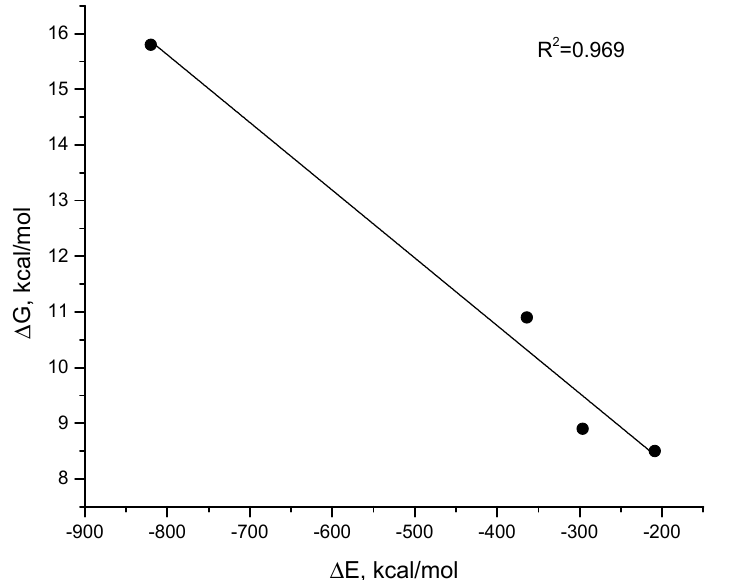
Figure 5. Correlation of the data obtained experimentally (ITC) and by MD simulations analysis (MM-GBSA). The x -axis shows the energies resulting from the MD analysis of the complex trajectories in kcal/mol, and the y -axis shows the Δ G from the ITC experiments, in kcal/mol.